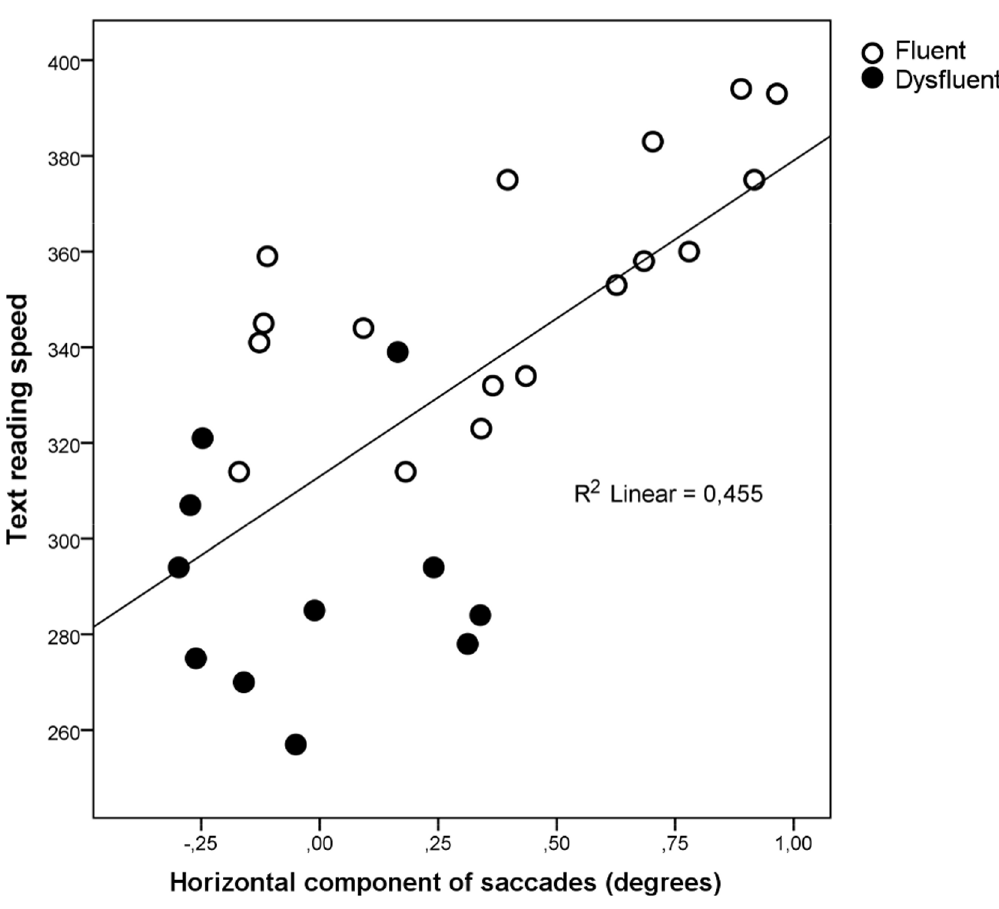
Figure 8. The correlation between text-reading speed (words in three minutes) and horizontal movement of the first saccade to late deviating nonwords.